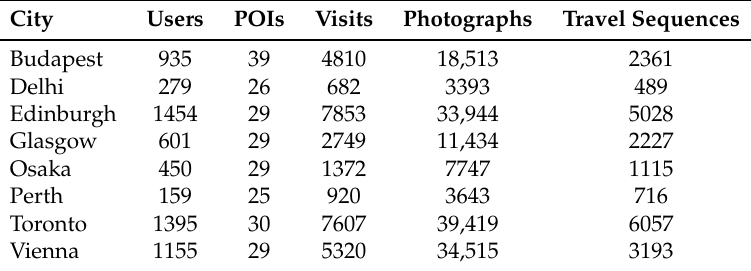
Table 5. The Flickr User-POI Visits Dataset [33,34].